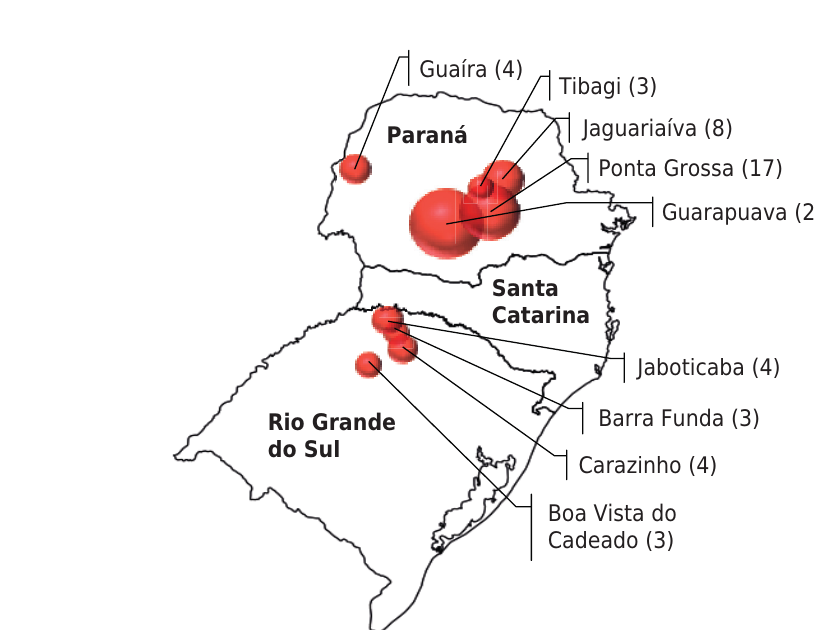
Figure 1. Geographic distribution and number of growing seasons in which crop grain yield was assessed as a function of gypsum rate in subtropical soils under no-tillage in South of